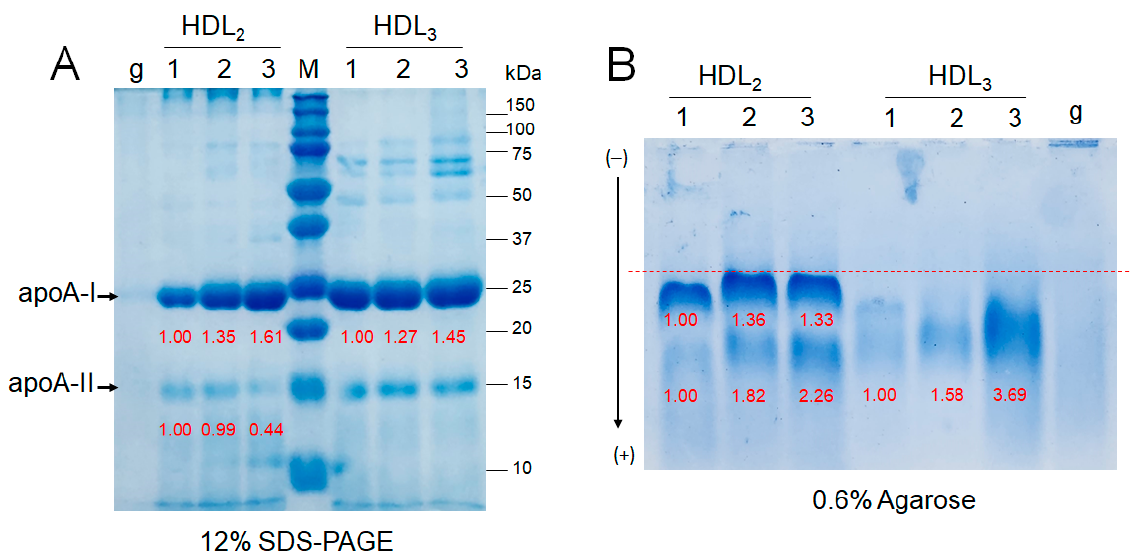
Figure 5. Electrophoretic patterns of HDL from participants depend on the exercise intensity. Lane 1, group 1 (n = 20); lane 2, group 2 (n = 16); lane 3, group 3 (n = 21). ( A ) Electrophoresis of HDL (2 mg/mL) under denatured state (12% SDS ‐ PAGE). Lane M, molecular weight standards (Bio ‐ Rad Cat#161 ‐ 0374); lane g, glycated HDL 2 . ( B ) Electrophoresis of HDL (2 mg/mL) under native state (0.6% agarose). Lane g, glycated HDL 3 .